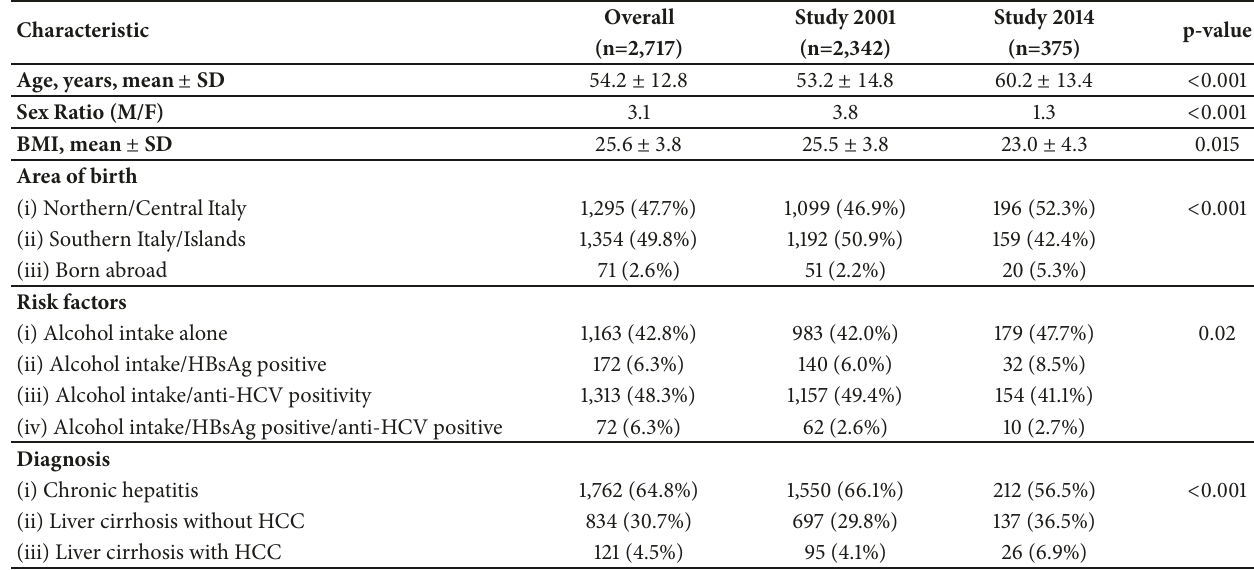
Table 1: Baseline characteristics of 2,717 enrolled subjects with chronic liver disease alcohol related in Italy, by year of recruitment. Characteristic